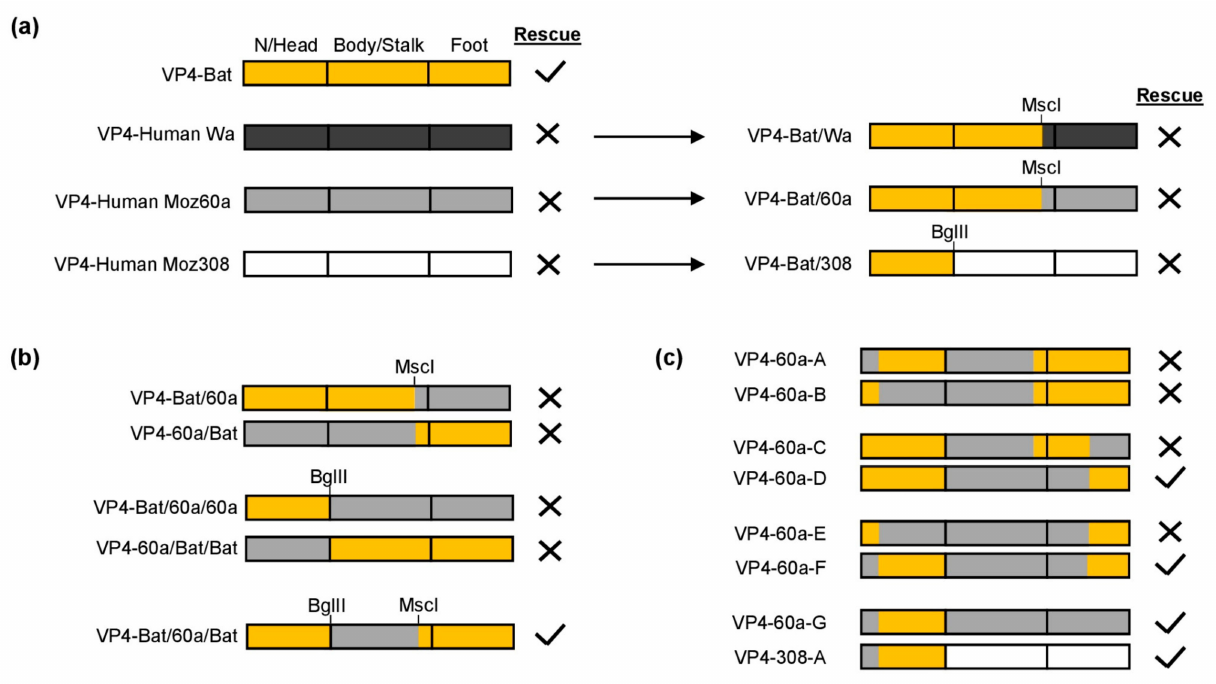
Figure 3. Chimeric bat/human VP4 constructs. N/Head: N-terminus and head region, Bat: orange, human Wa: dark gray, human Moz60a: light gray, human Moz308: white. Successful rescue was confirmed by the presence of a CPE and the detection of viral RNA by qRT-PCR. Negative rescue was confirmed by the absence of a CPE and no detection of viral RNA by qRT-PCR. ( a ) Chimeric genome segments with nucleotides encoding the head region derived from VP4-Bat and the foot region derived from human strains. ( b ) VP4-encoding genome segments with sequences from VP4-Bat and VP4-Human Moz60a ( c ) Genome segments encoding VP4 with different combinations of the N-terminus and foot